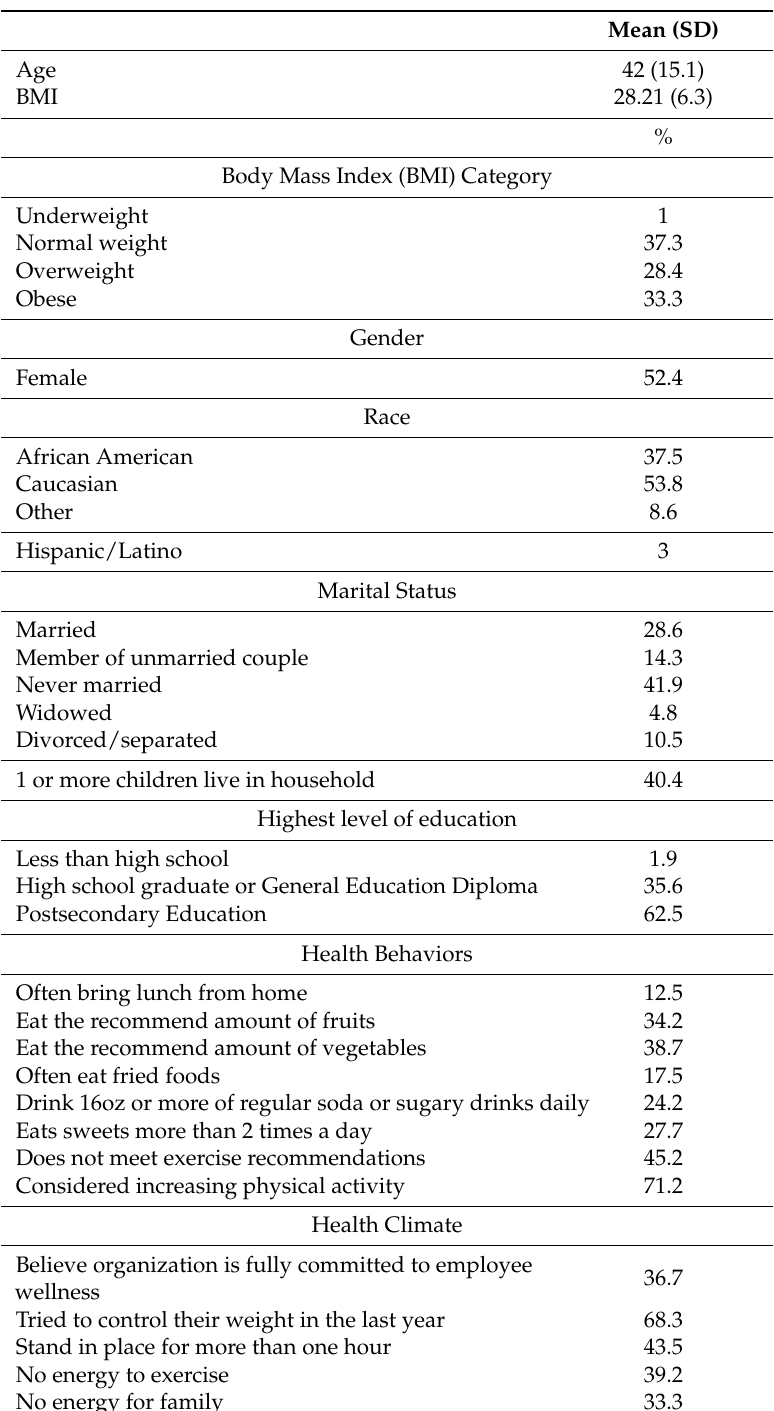
Table 1. Demographics of the Baseline Survey